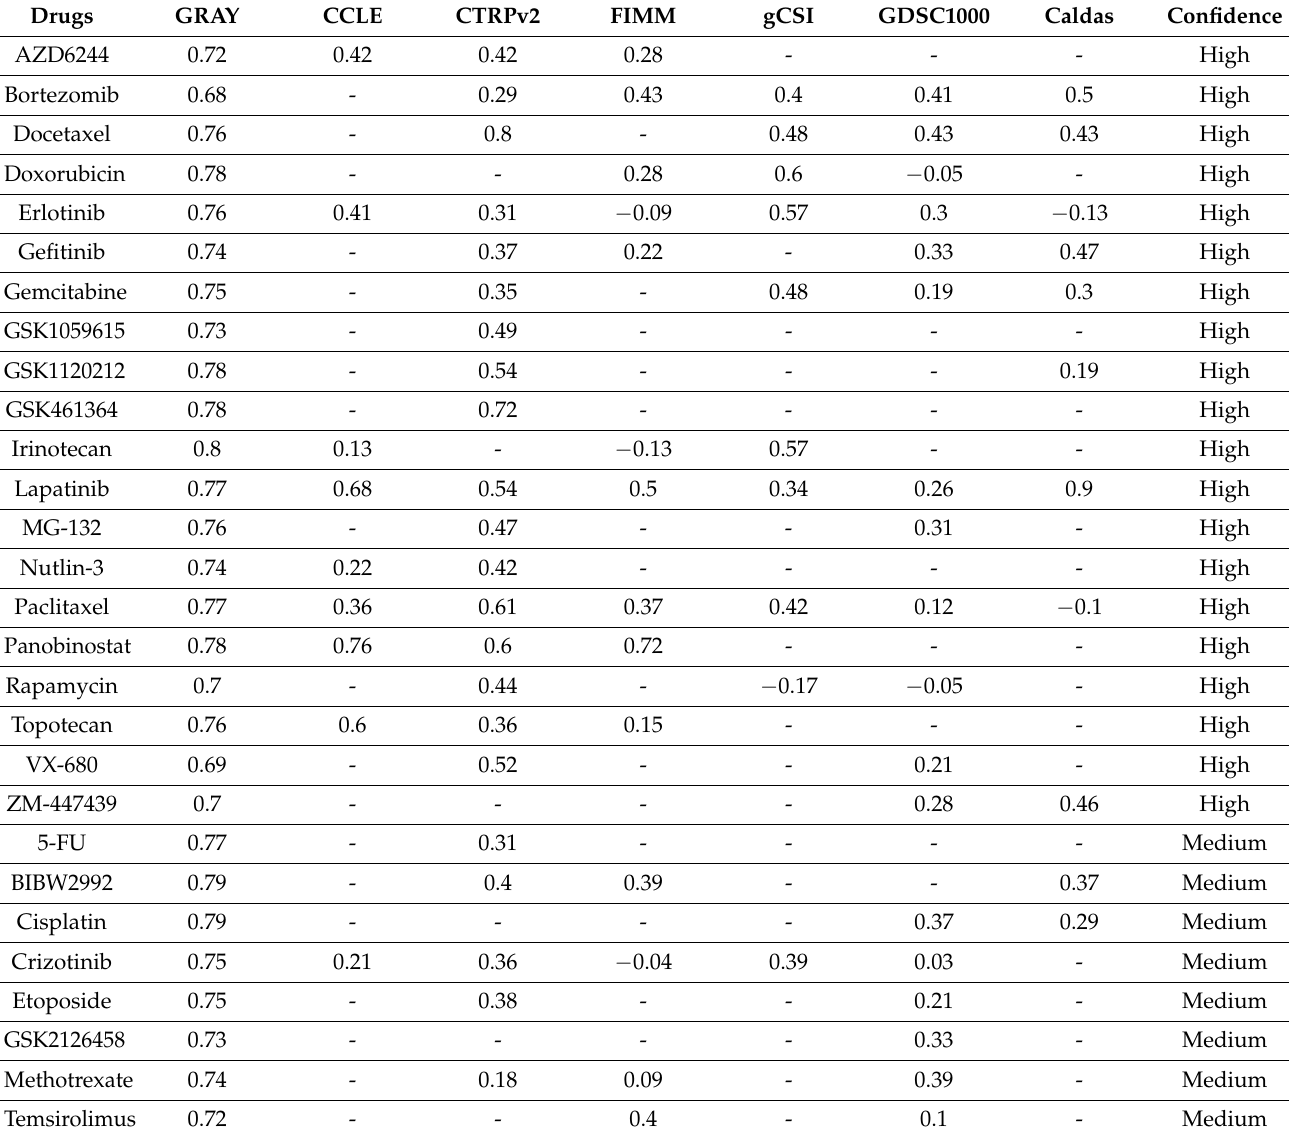
Table 2. Spearman’s correlation coefficients ( ρ ) between drug efficacy signature scores and observed drug response. The Gray data were used to generate drug efficacy signature scores. Drugs with ρ ≥ 0.4 in at least one test set (high-confidence) and drugs with 0.4 > ρ ≥ 0.3 (medium confidence) are shown. Table S2 shows this information for all the 90